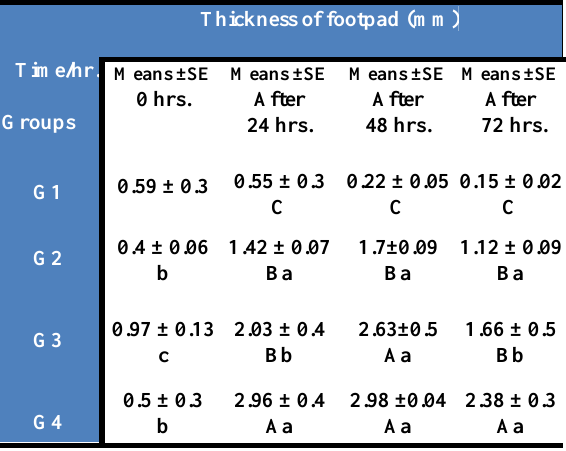
Table, 2: The mean of footpad thickness in vaccinated groups of mice (G2, G3, G4) and non- vaccinated group (G1) after 27 days of immunization. Thickness of footpad Time/hr. Groups